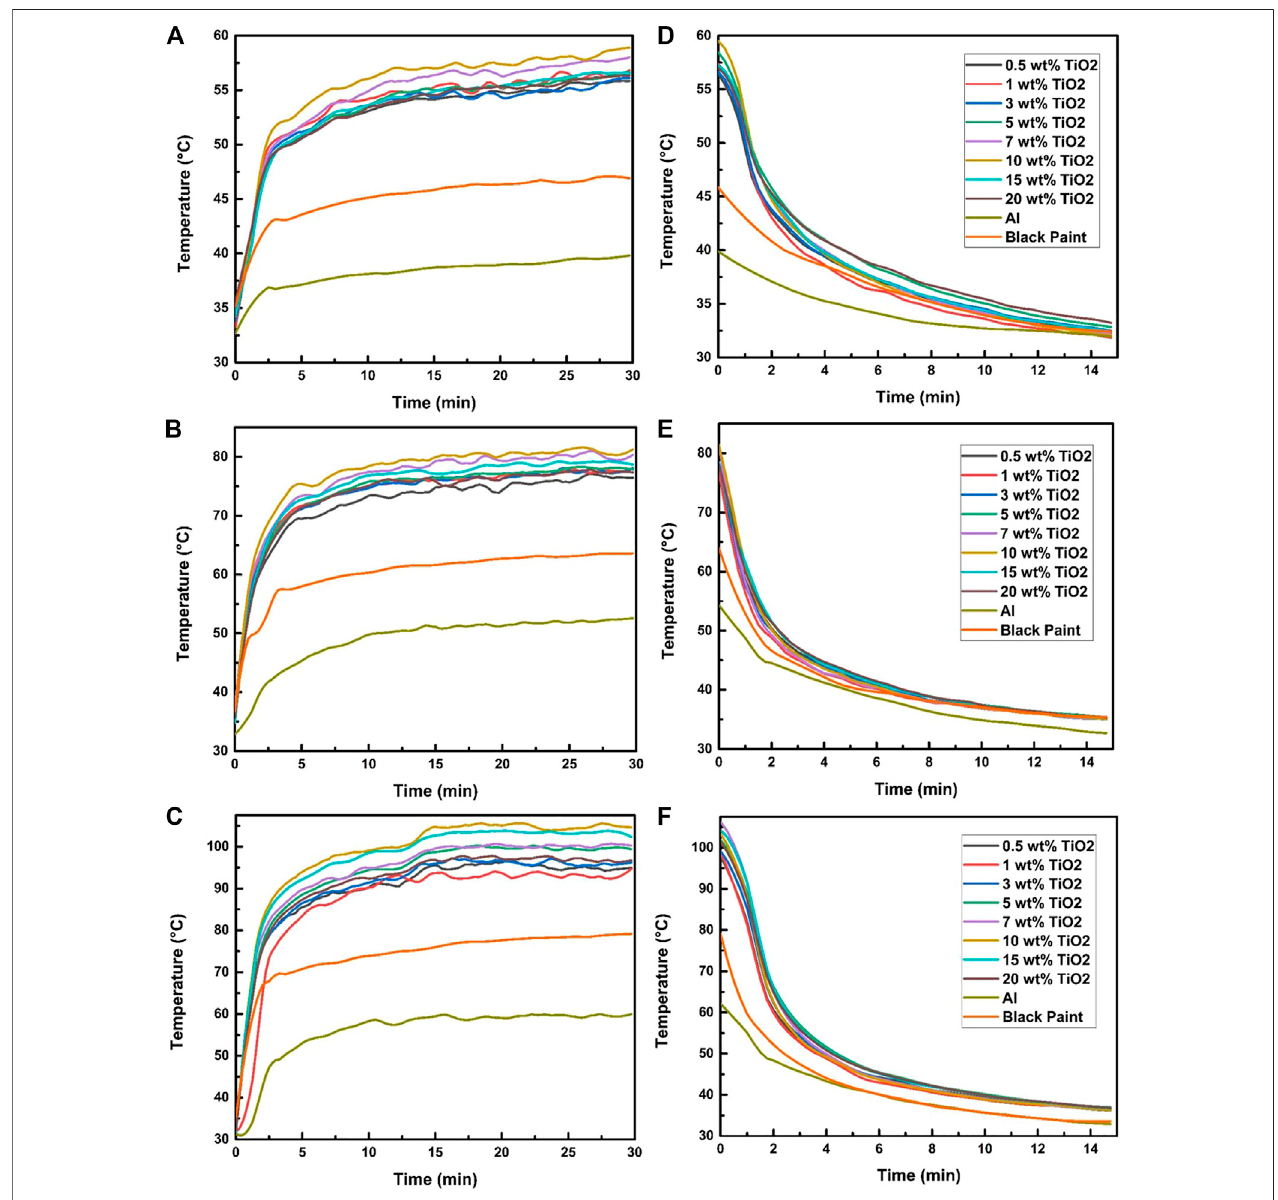
FIGURE 5 | Effect of TiO 2 -150 nm on the absorber temperature at irradiation exposure of (A) 200 W/m 2 , (B) 600 W/m 2 , and (C) 1,000 W/m 2 and (D – F) temperature drop pro fi le.